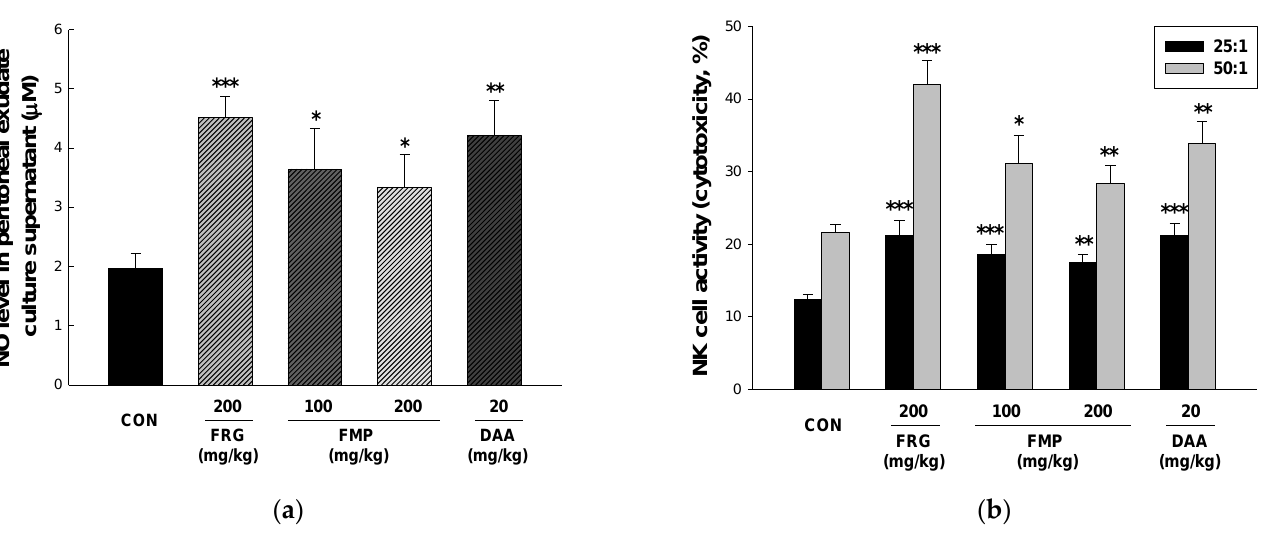
Figure 3. Effects of FMP on NO Production and NK cell cytotoxicity in peritoneal exudate cells and splenocytes from Balb/c mice, respectively. After oral administration for 12 days, peritoneal exudate cells were elicited by injecting 2% starch saline for 48 h and harvested. ( a ) NO production was determined using a Griess reagent assay. The splenocytes were co-cultured with target cells (YAC-1) for 4 h with a ratio of effector to target cells of 25:1 and 50:1. ( b ) NK cell cytotoxicity was determined using a LDH activity assay. All values are expressed as the mean ± standard error. * p < 0.05, ** p < 0.01, and * * * p < 0.001 vs. no treatment group. FRG, fermented red ginseng extract; FMP, fermented